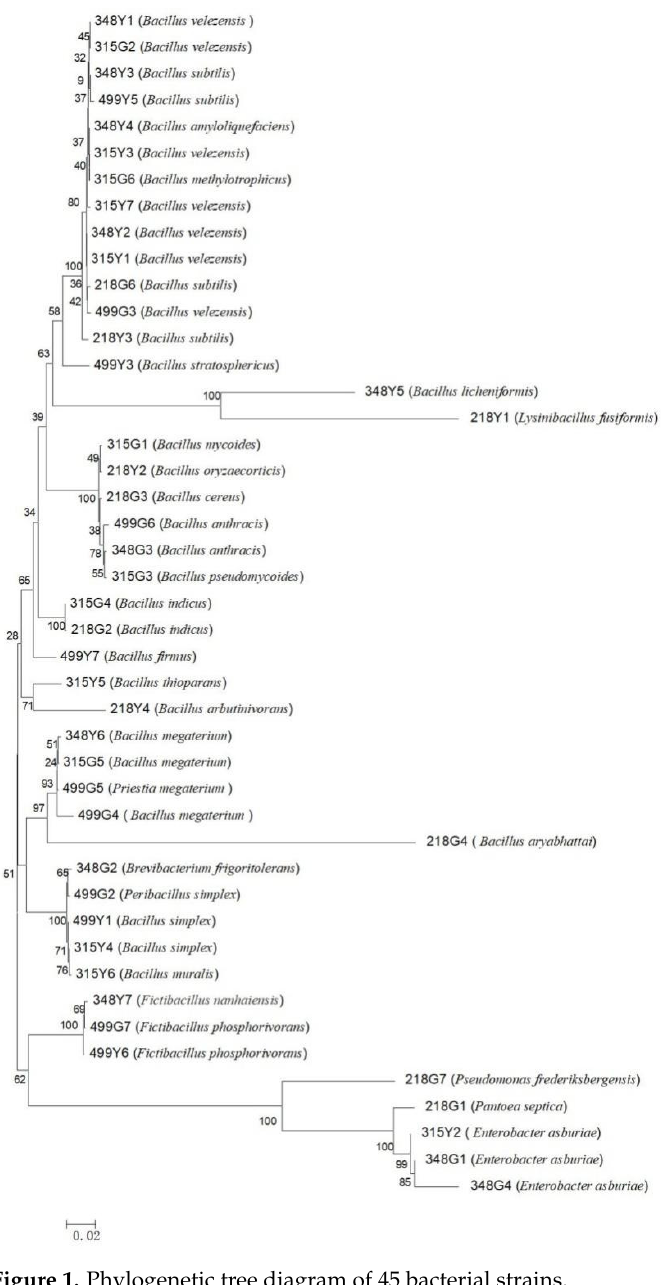
Figure 1. Phylogenetic tree diagram of 45 bacterial strains.